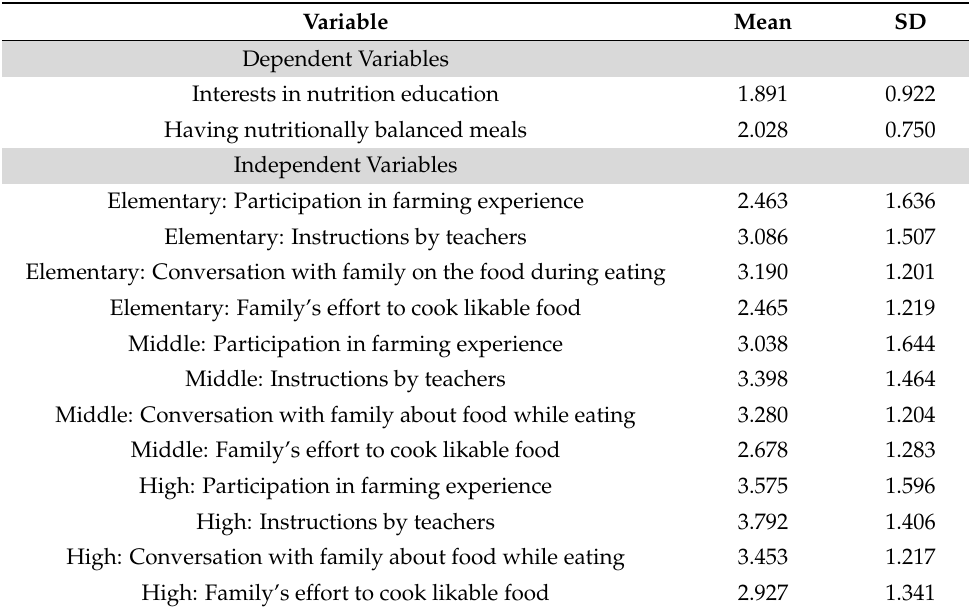
Table 2. Summary statistics of the key variables ( n =